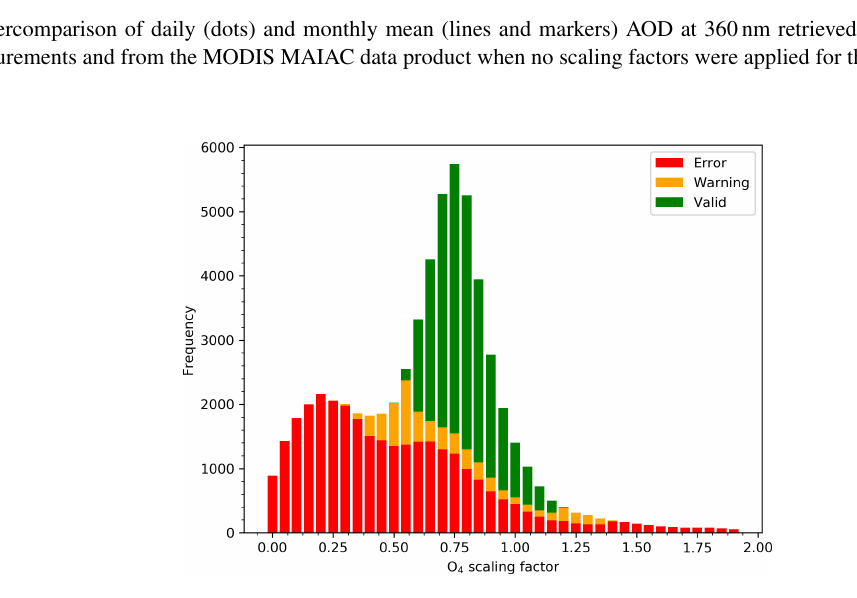
Figure F12. Frequency distribution of O 4 scaling factors derived from profile inversions, which allowed us to vary the O 4 scaling factors in order to achieve an agreement between measurements and forward model. The green bars show retrievals which are flagged as valid, while the orange and red bars indicate retrievals with warning and error flags.